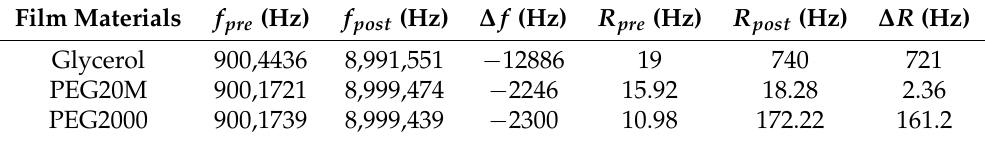
Table 4. Film coating